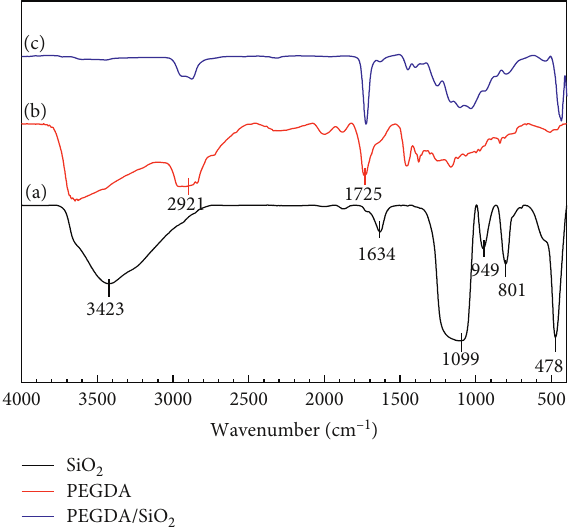
Figure 1: FT-IR spectra of SiO 2 (curve (a)), PEGDA (curve (b)), and PEGDA/SiO 2 (curve (c)).